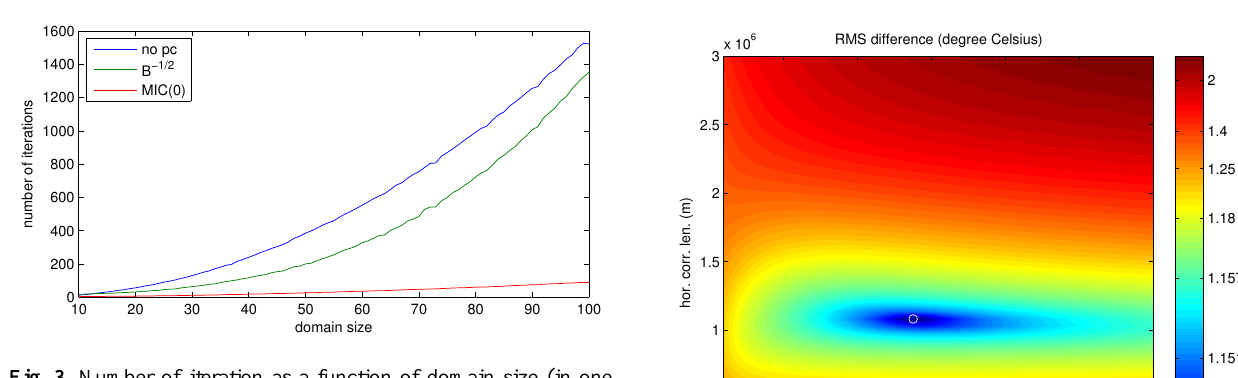
Fig. 3. Number of iteration as a function of domain size (in one dimension). The number of grid points if the domain size is squared. Table 5. Run time in seconds for different domain sizes for MAT- LAB (R2012b) and Octave version 3.6.4 (using GotoBLAS2 or MKL) for the dual algorithm. Fig. 4. RMS difference between the reference climatology and the analysis for different values of signal-to-noise ratio and correlation length. A non-linear colour-map is used to enhance detail near the minimum.